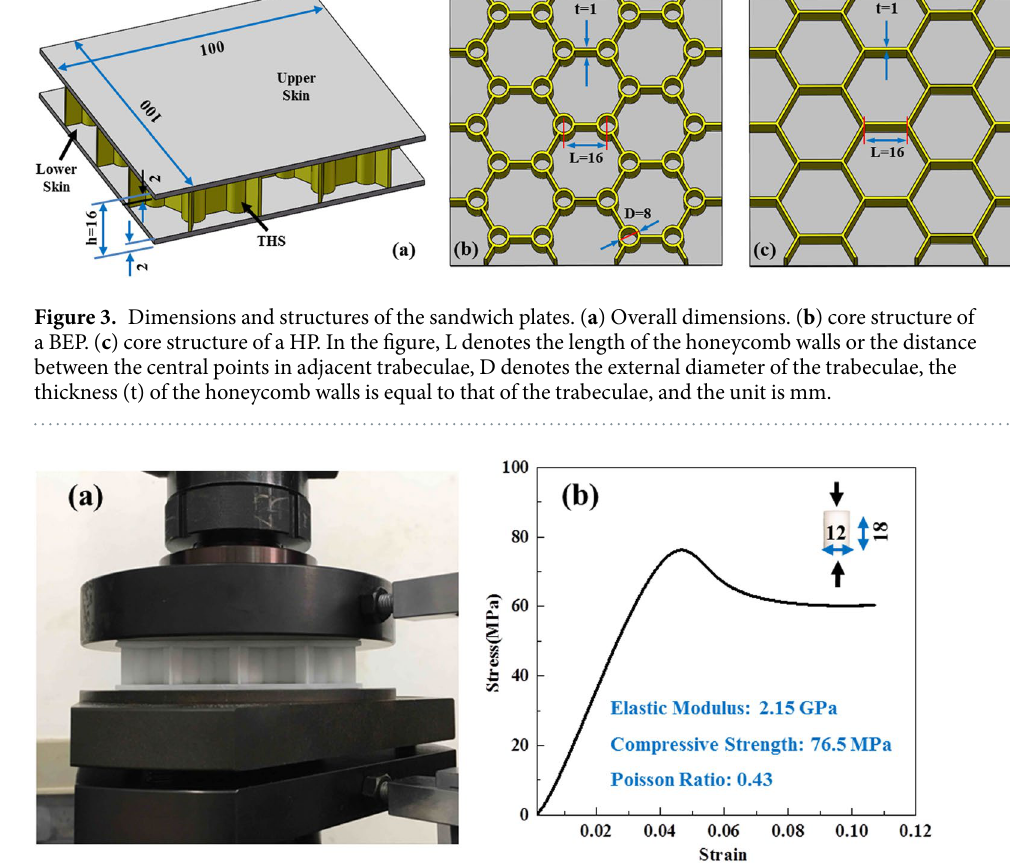
Figure 4. Experiment and material property. ( a ) The experimental process. ( b ) The constitutive curve of